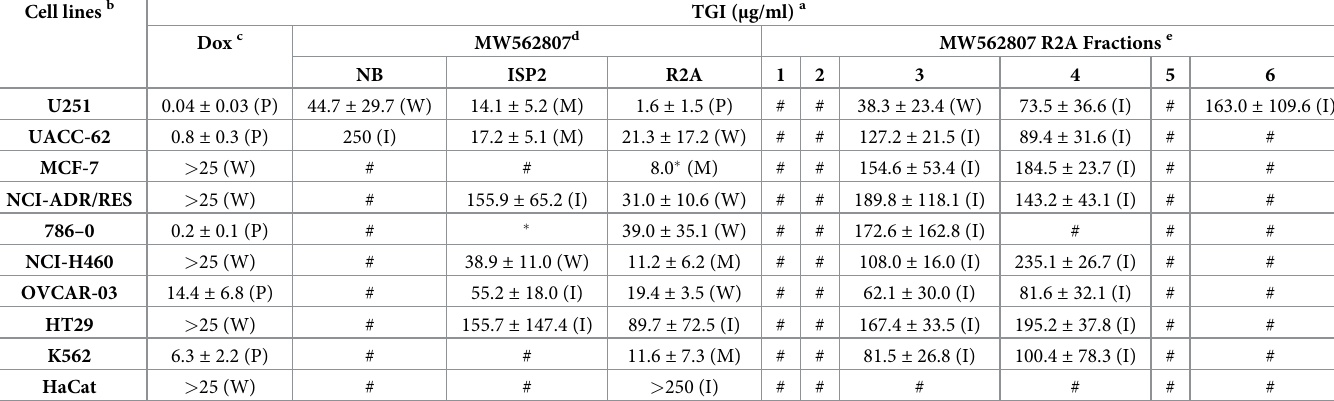
Table 5. Antiproliferative evaluation of isolate Streptomyces sp. MW562807 fermented in three different media and fractions of the R2A medium against nine tumors and one non-tumor cell line. Cell lines